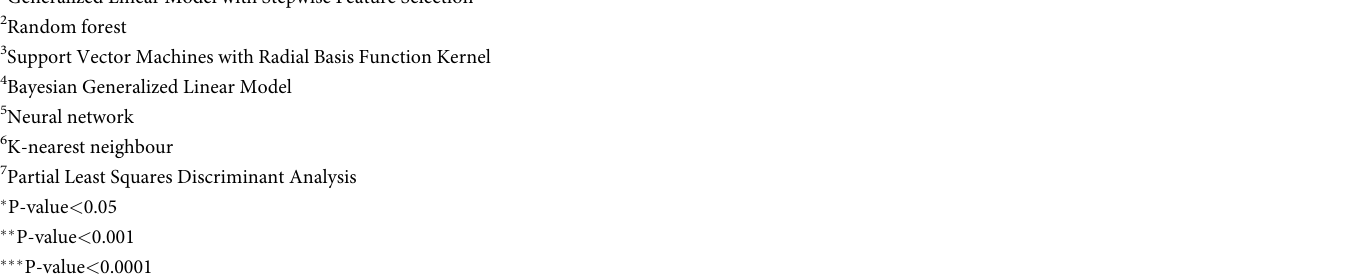
1 Generalized Linear Model with Stepwise Feature Selection 2 Random forest 3 Support Vector Machines with Radial Basis Function